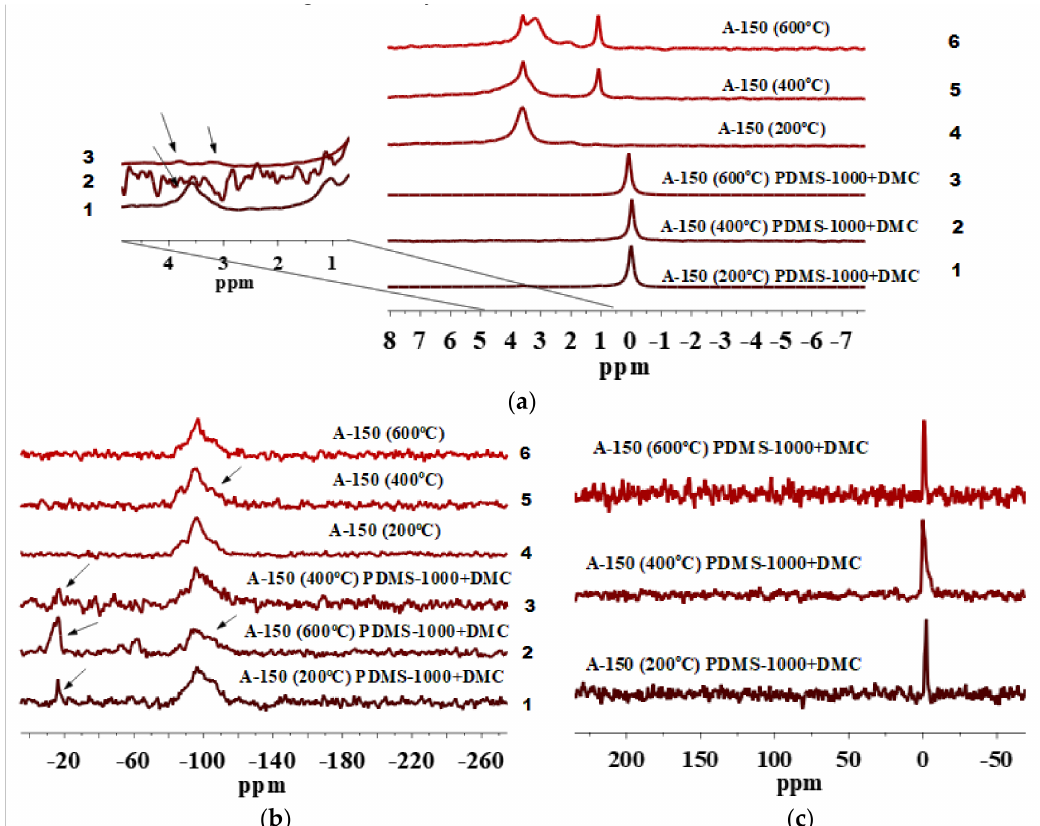
Figure 4. ( a ) 1 H MAS NMR, ( b ) 29 Si CP/MAS NMR, and ( c ) 13 C CP/MAS NMR spectra of A-150 preheated at 200, 400, and 600 ◦ C and modified by